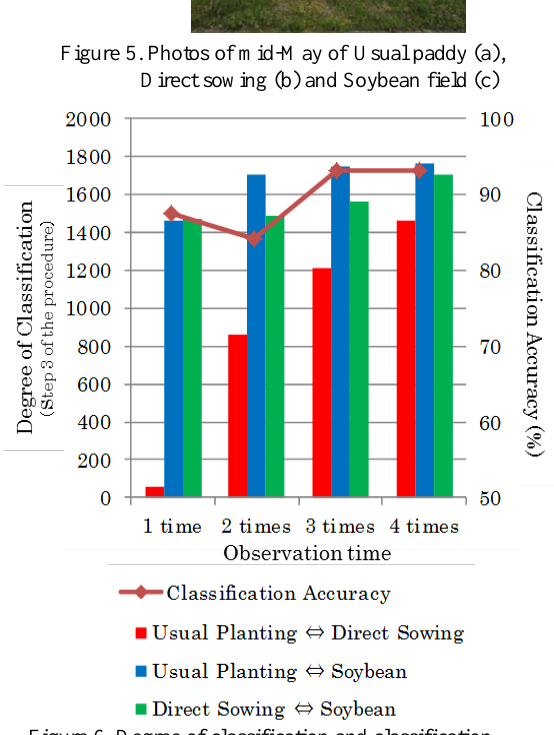
Figure 6. Degree of classification and classification accuracy by selecting 1 to 4 observation